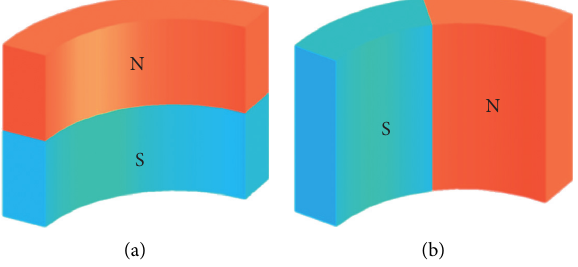
Figure 6: Magnetizing mode of the tile magnet. (a) Axial magnetization. (b) Circular magnetization.